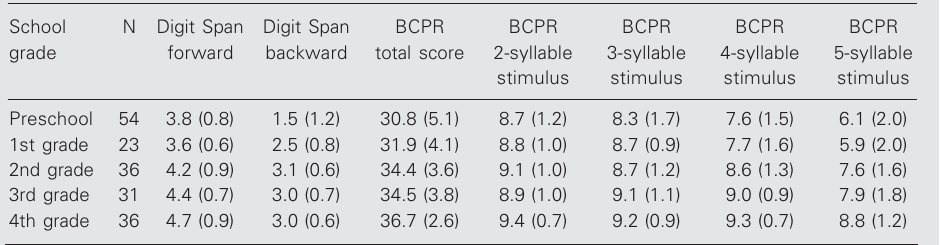
Table 3. Validity study of Digit Span and BCPR by school grade (N = 180).